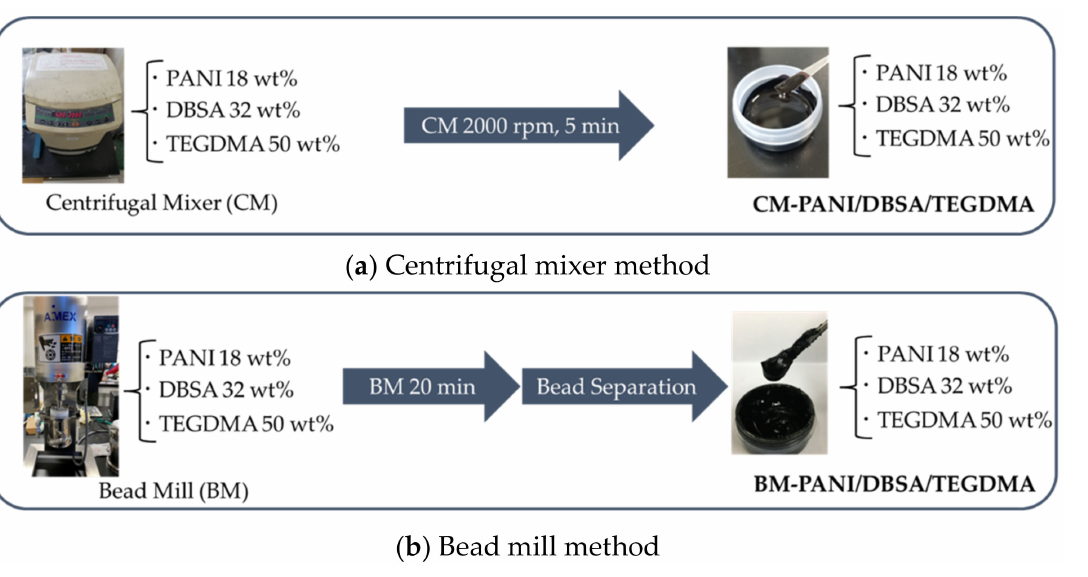
Figure 2. Procedures used to produce PANI/DBSA/TEGDMA composites in conjunction with ( a ) centrifugation and ( b ) bead